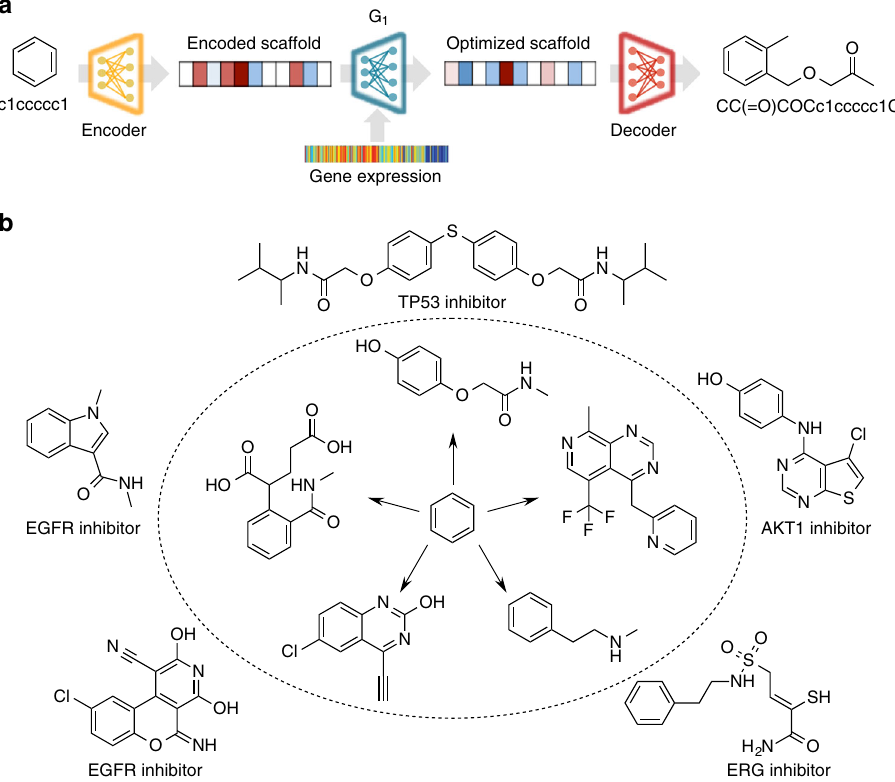
Fig. 4 Examples of optimizing the benzene ring scaffold towards different targets using gene expression signatures. a The encoder (in yellow) transforms the SMILES of the scaffold into a latent representation that is fed into the Stage II generator ( G 1 in blue) together with the desired gene expression signature. The output of G 1 is the latent representation of an optimized molecule that can be decoded into a compound with a high probability to produce the gene expression signature. b Molecules generated by optimizing the benzene ring using the knock-out gene expression of AKT1, EGFR, ERG, and TP53 are shown inside the dotted circle and their closest active nearest neighbor outside the